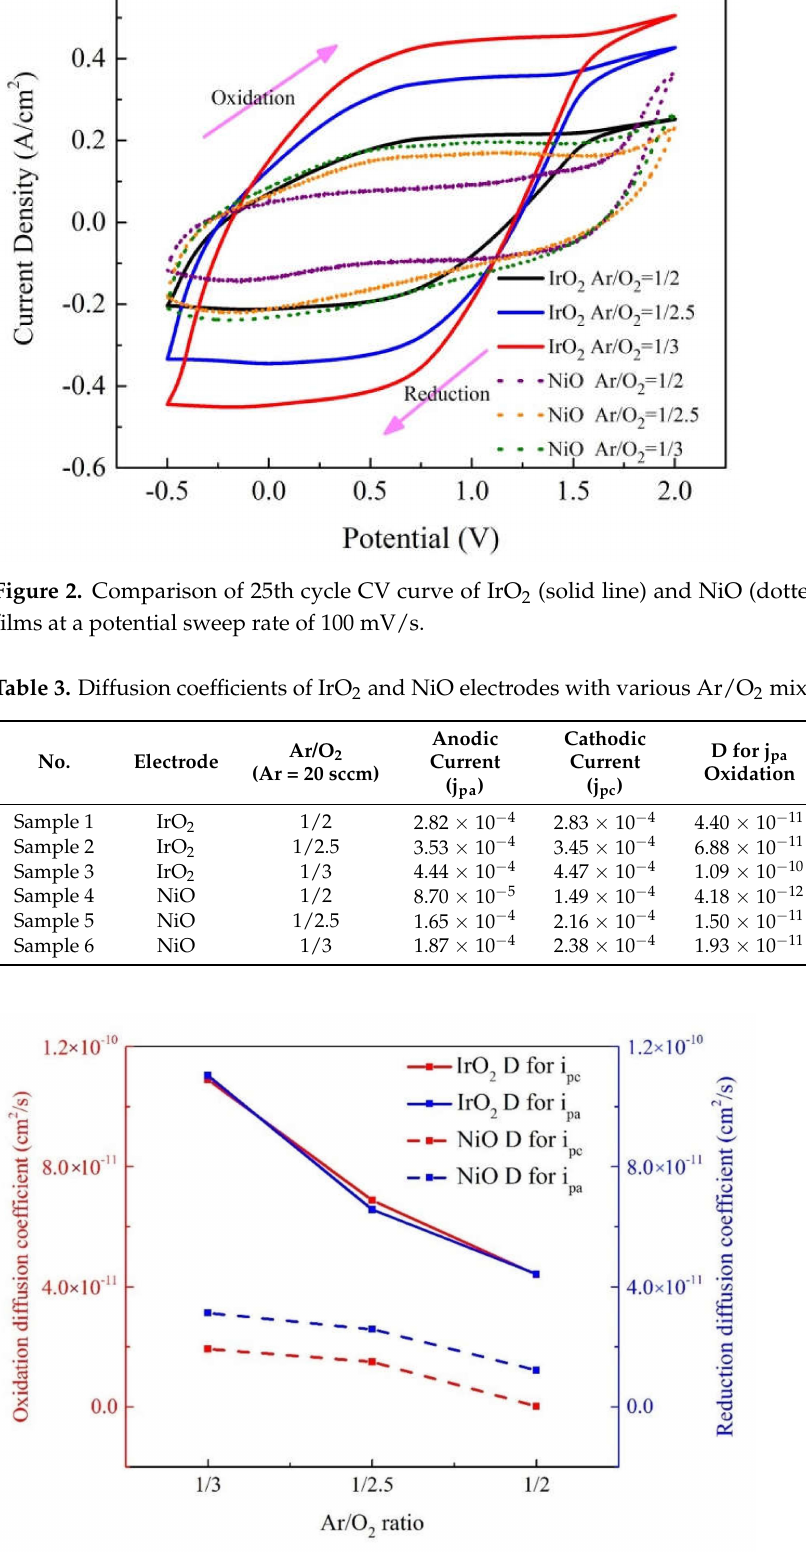
Figure 3. The comparison of diffusion coefficients of IrO 2 and NiO electrodes with various Ar/O 2 mixing